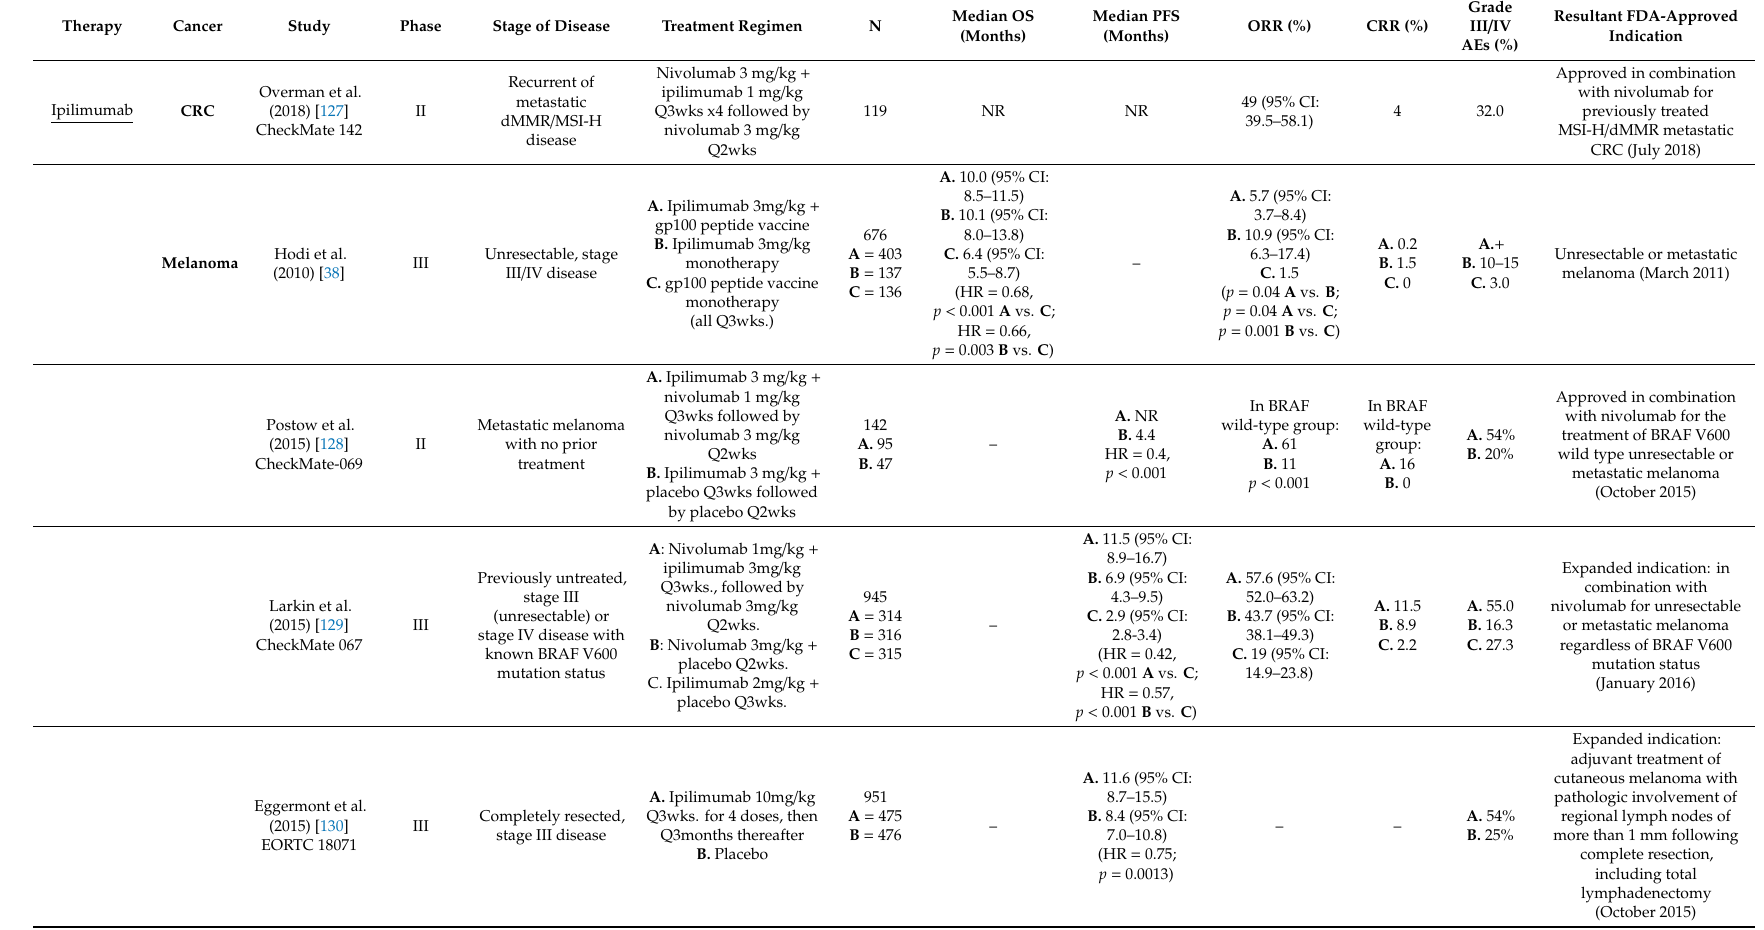
Table A2. Clinical data for CTLA-4